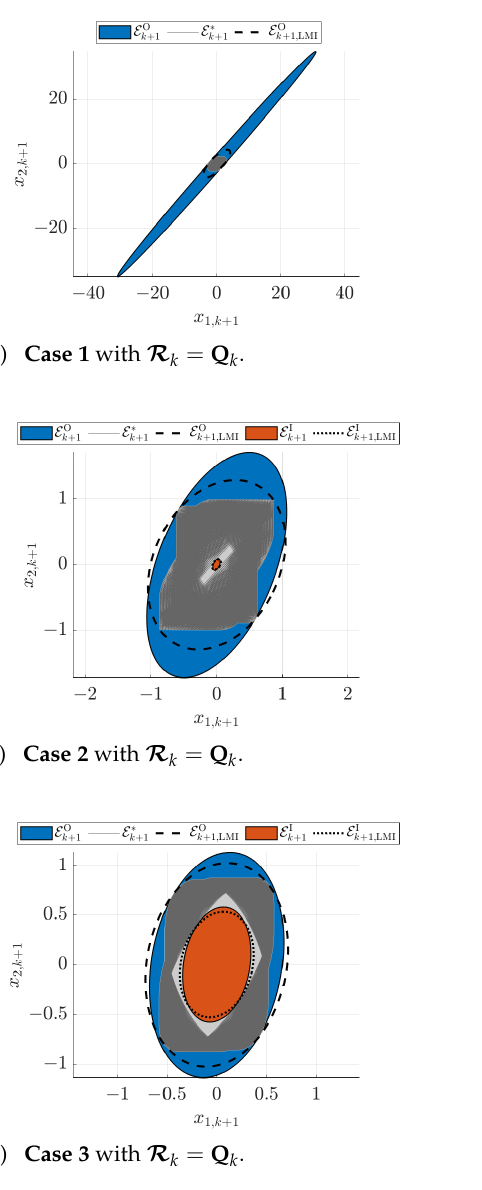
Figure 2. Computation of the thick ellipsoid enclosure (( E )) solution sets are visualized in light gray color, while the dark gray domains consist of the union of ellipsoid bounds that result from a numerical mapping of a 20 × 20 grid for the interval parameters [ p ] and [ p ] 2 1